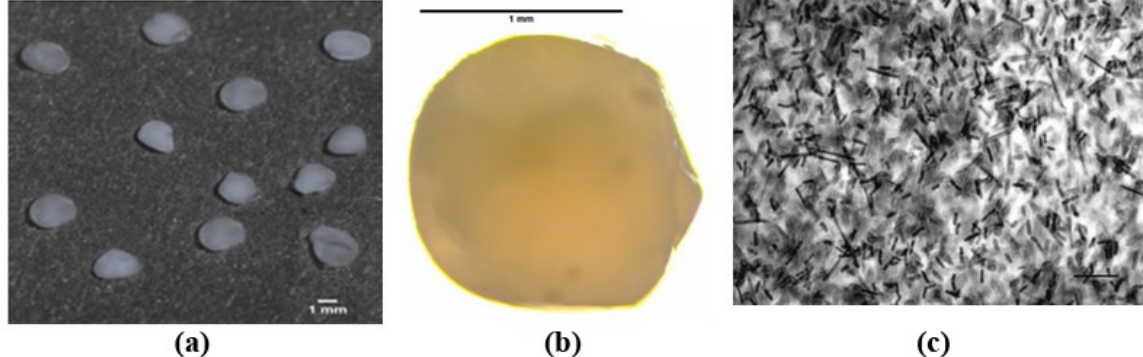
Figure 2 - Photographic images of alginate/gelatin beads (1 % w/v of alginate and 0.1 % w/v of gelatin). (a) Direct observation; (b) Microscopy image (x40 magnification); (c) Cross section of bead (x1000